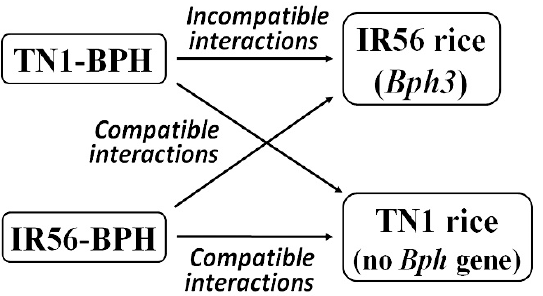
Figure 1. A schematic indicating the compatible and incompatible interactions among the rice varieties and brown planthopper (BPH) populations used in this study.